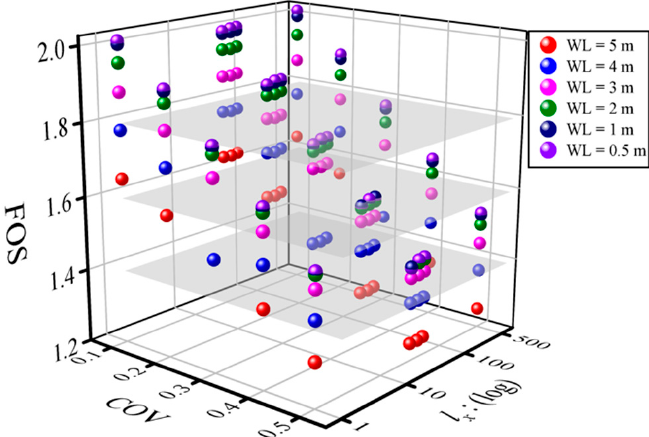
Figure 9. The result of FOSs from random field analysis.